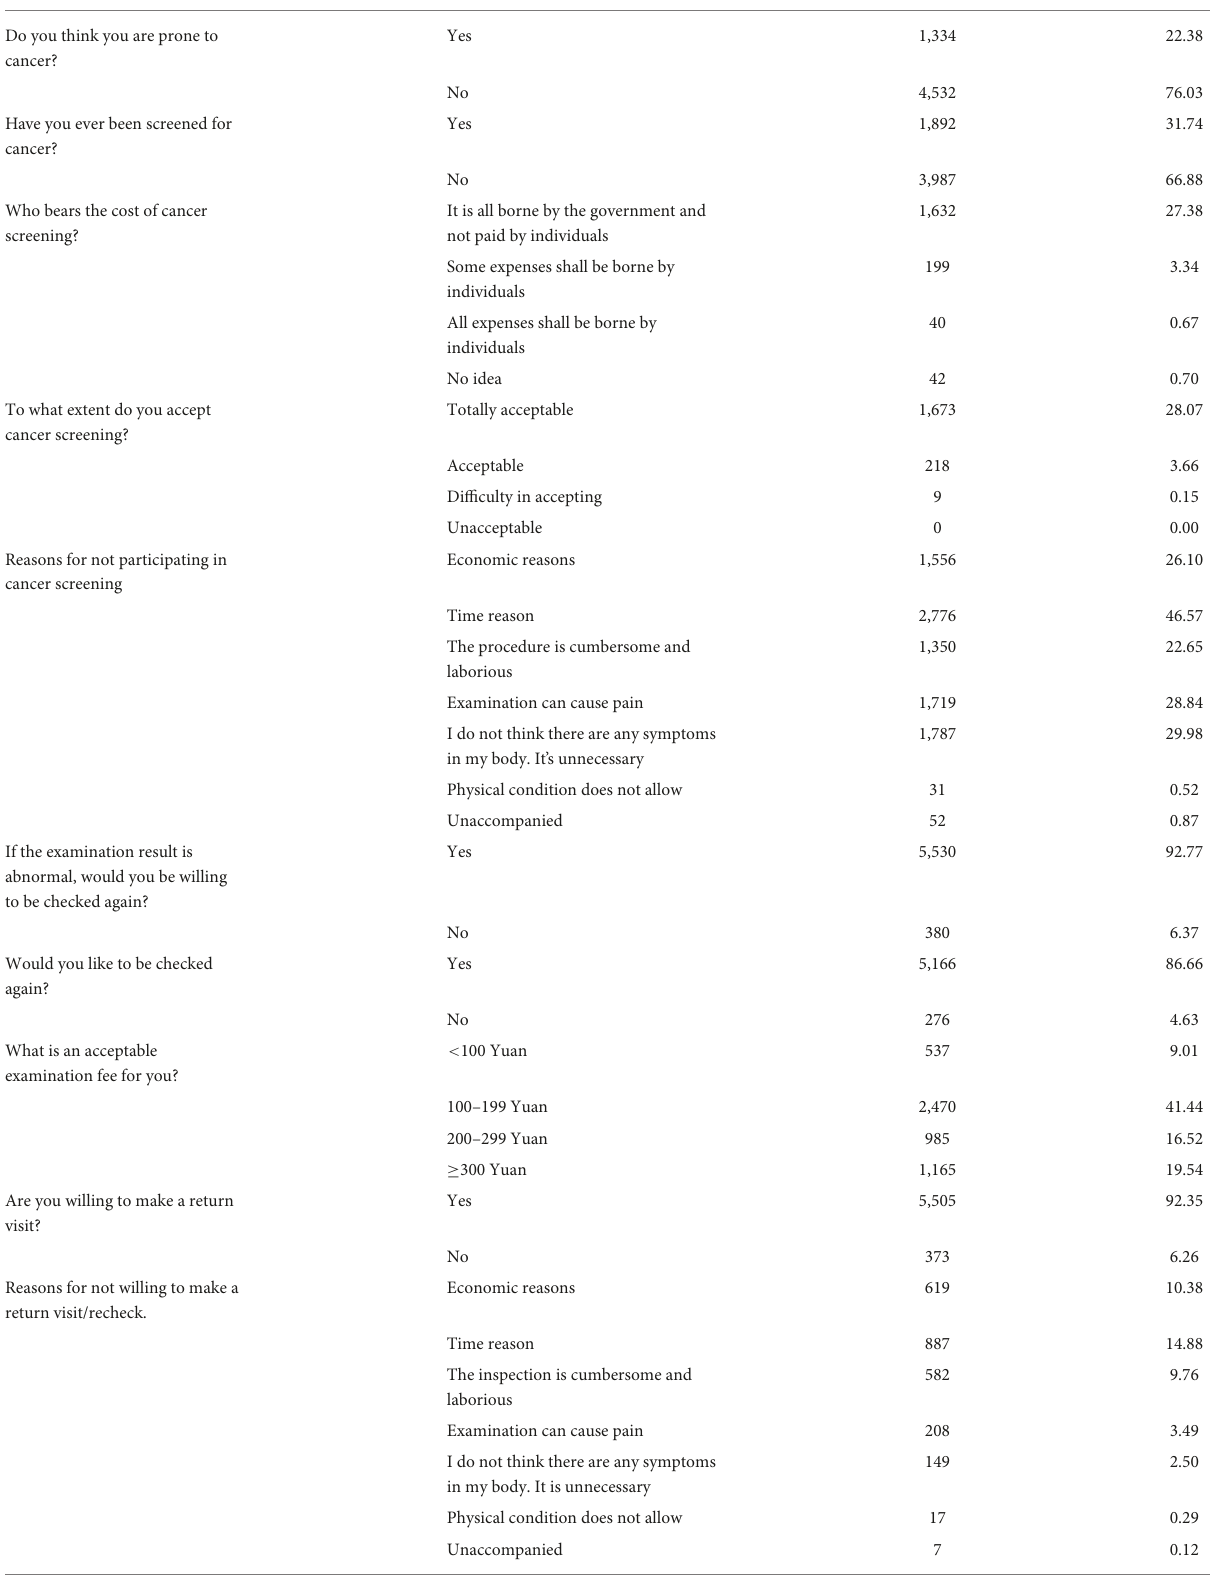
TABLE 5 Screening willingness of the cervical cancer screening population. Characteristics